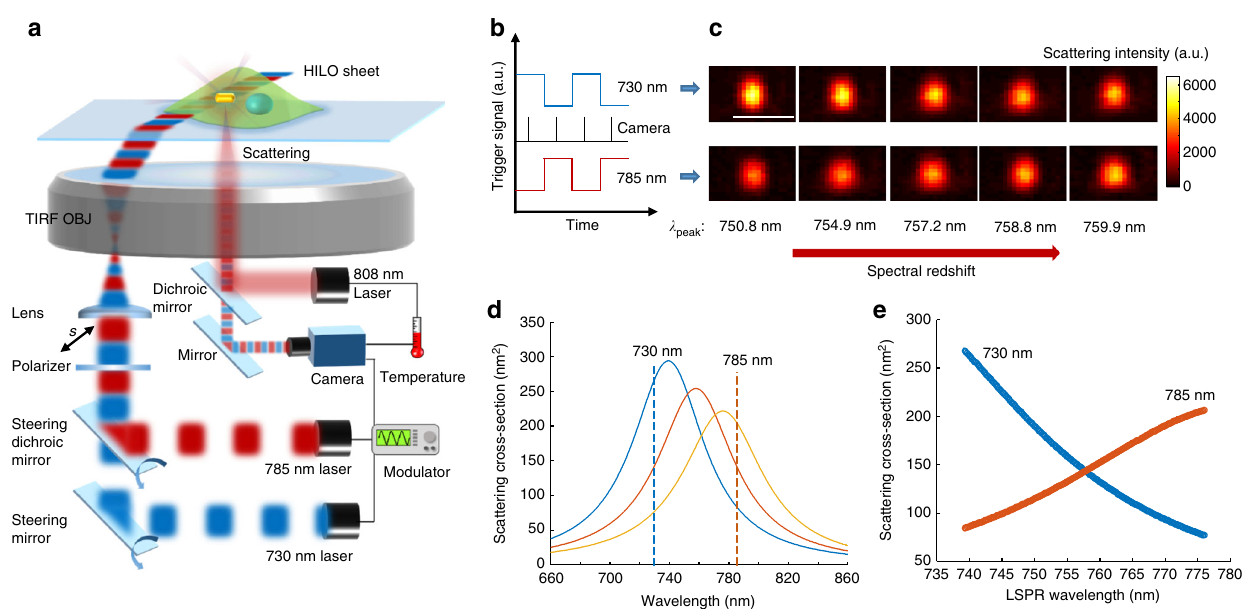
Fig. 2 Work principle of the spatiotemporal resolution plasmonic spectroscopy (SRPS). a Schematic illustration of SRPS set-up. An s-polarized two-color pulse beam with switchable wavelength between 730 and 785 nm is generated by combining two antiphase pulse lasers, which is then directed onto the cover slide with a high incident angle to form the highly inclined and laminated optical (HILO) sheet. The thin optical sheet excites the LSPR scattering of gold nanorods. The scattering light is then collected by a camera to form two-channel dark- fi eld images, which are then converted to the spectral mapping. Another 808-nm laser is focused on the single-nanoparticle for in situ heat generation. b Trigger signal waveforms of the 730-nm (blue), 785-nm (red) laser and the camera (black) are generated by a waveform generator. c Two-channel snapshots of a single gold nanorod with the LSPR wavelength adjusted from 750.8 to 759.9 nm. d Simulated scattering spectra of a gold nanorod when adjacent dielectric functions are changed from 1.67 to 1.87. e Scattering cross-sections of the gold nanorod in d at 730 (blue) and 785 nm (red) as functions of the LSPR